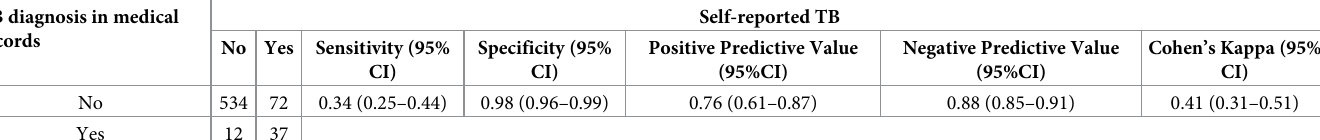
Table 5. Sensitivity, specificity, positive and negative predictive values and agreement of TB based on medical records compared to self-reported TB of PLWH in Florida. TB diagnosis in medical